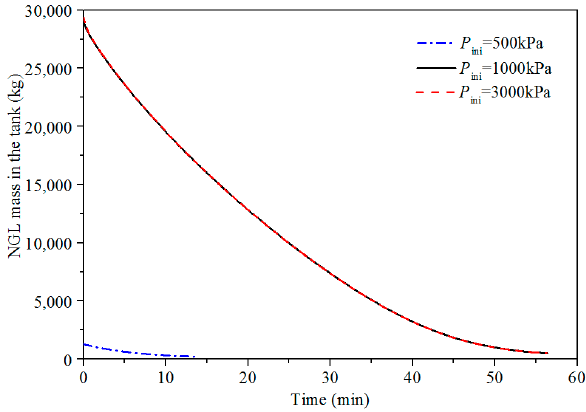
Figure 18. The residual NGL mass in the tank at different initial tank pressures.